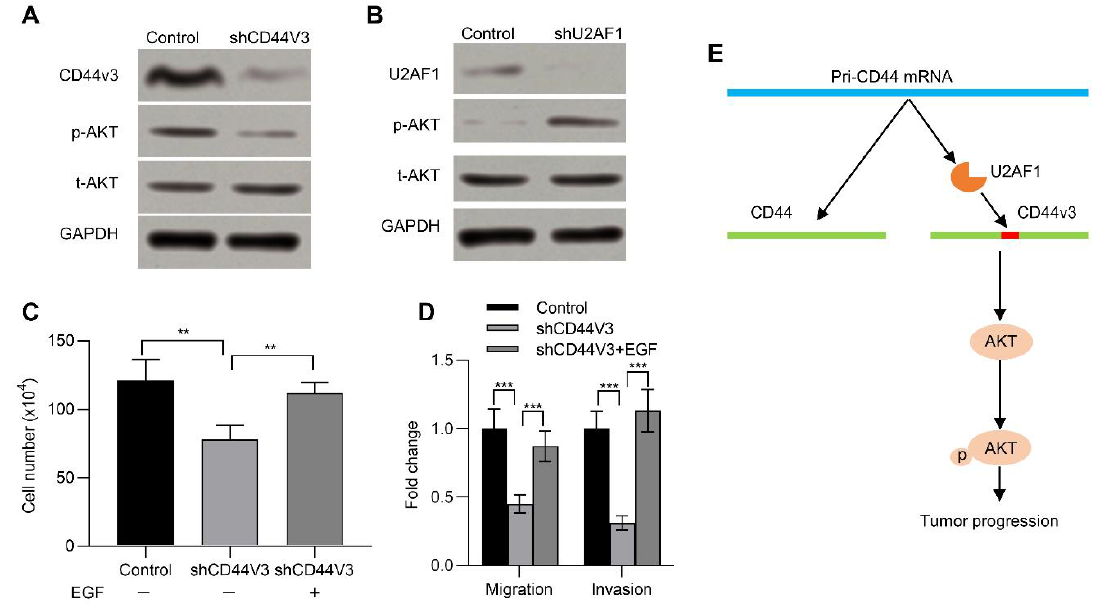
Figure 6. CD44V3 increased the AKT signaling pathway. ( A ) The p-AKT and t-AKT levels in AsPC-1 cells transfected with CD44V3 shRNA were determined by Western blot. ( B ) The p-AKT and t-AKT levels in AsPC-1 cells transfected with U2AF1 shRNA were determined by Western blot. ( C ) Cell count assay of AsPC-1 cells transfected with CD44V3 shRNA and treated with or without recombinant EGF. ( D ) Transwell migration and invasion assay of the AsPC-1 cells transfected with CD44V3 shRNA and treated with or without recombinant EGF. ( E ) A graphical abstract of the role of CD44V3 in tumor progression. The data are presented as mean ± S.D. ** p < 0.01; *** p < 0.001.